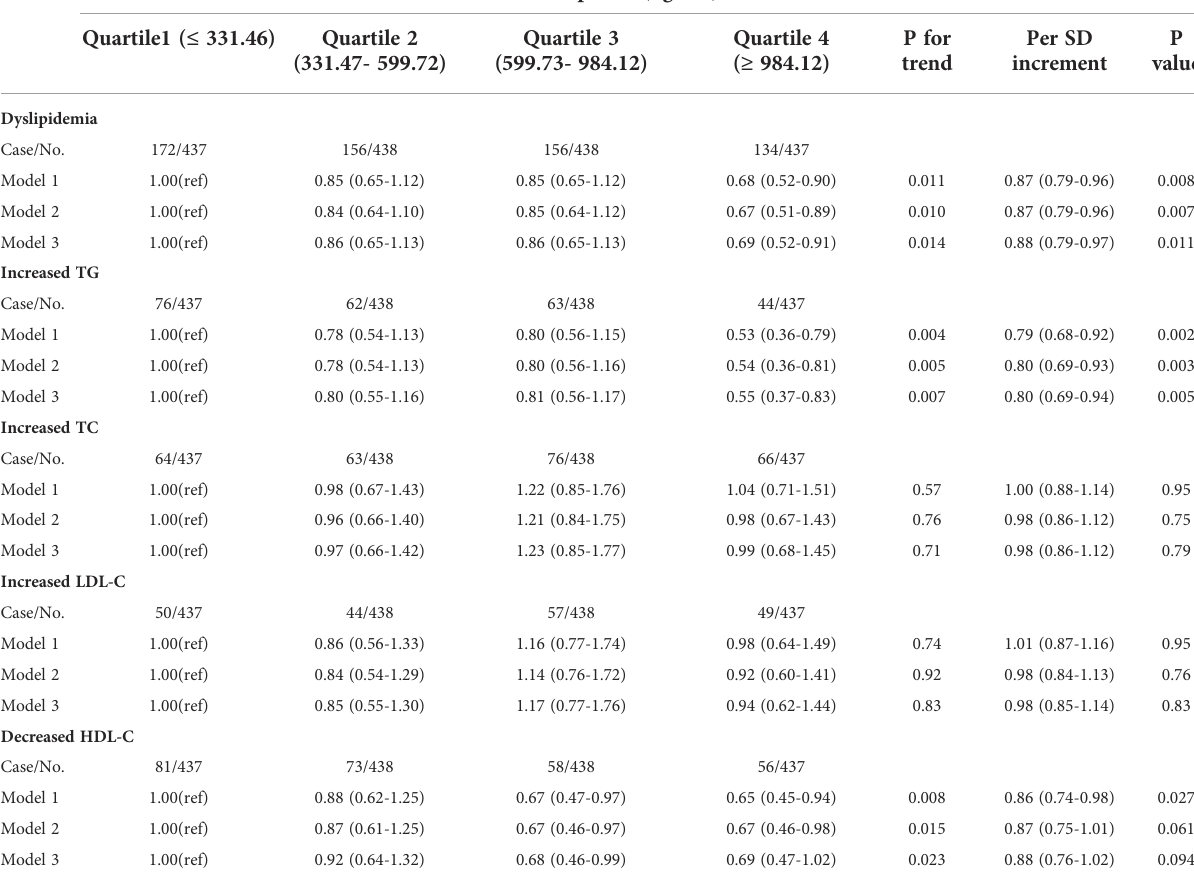
TABLE 3 Odds ratios (95% con fi dence intervals) for prevalent dyslipidemia according to serum Sparcl1